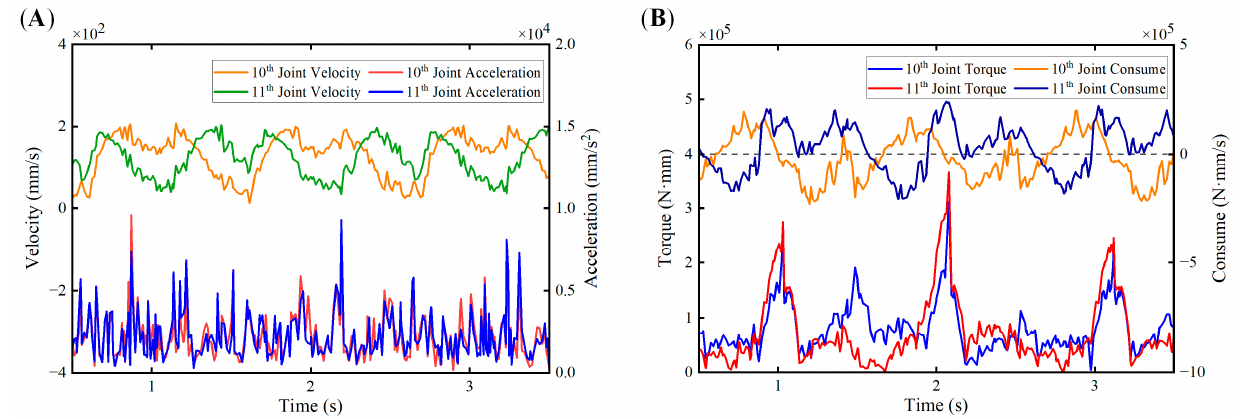
Figure 15. The mechanic characteristics of adjacent modules: ( A ) velocity and acceleration relative to time; and ( B ) joint torque and consumption relative to time.